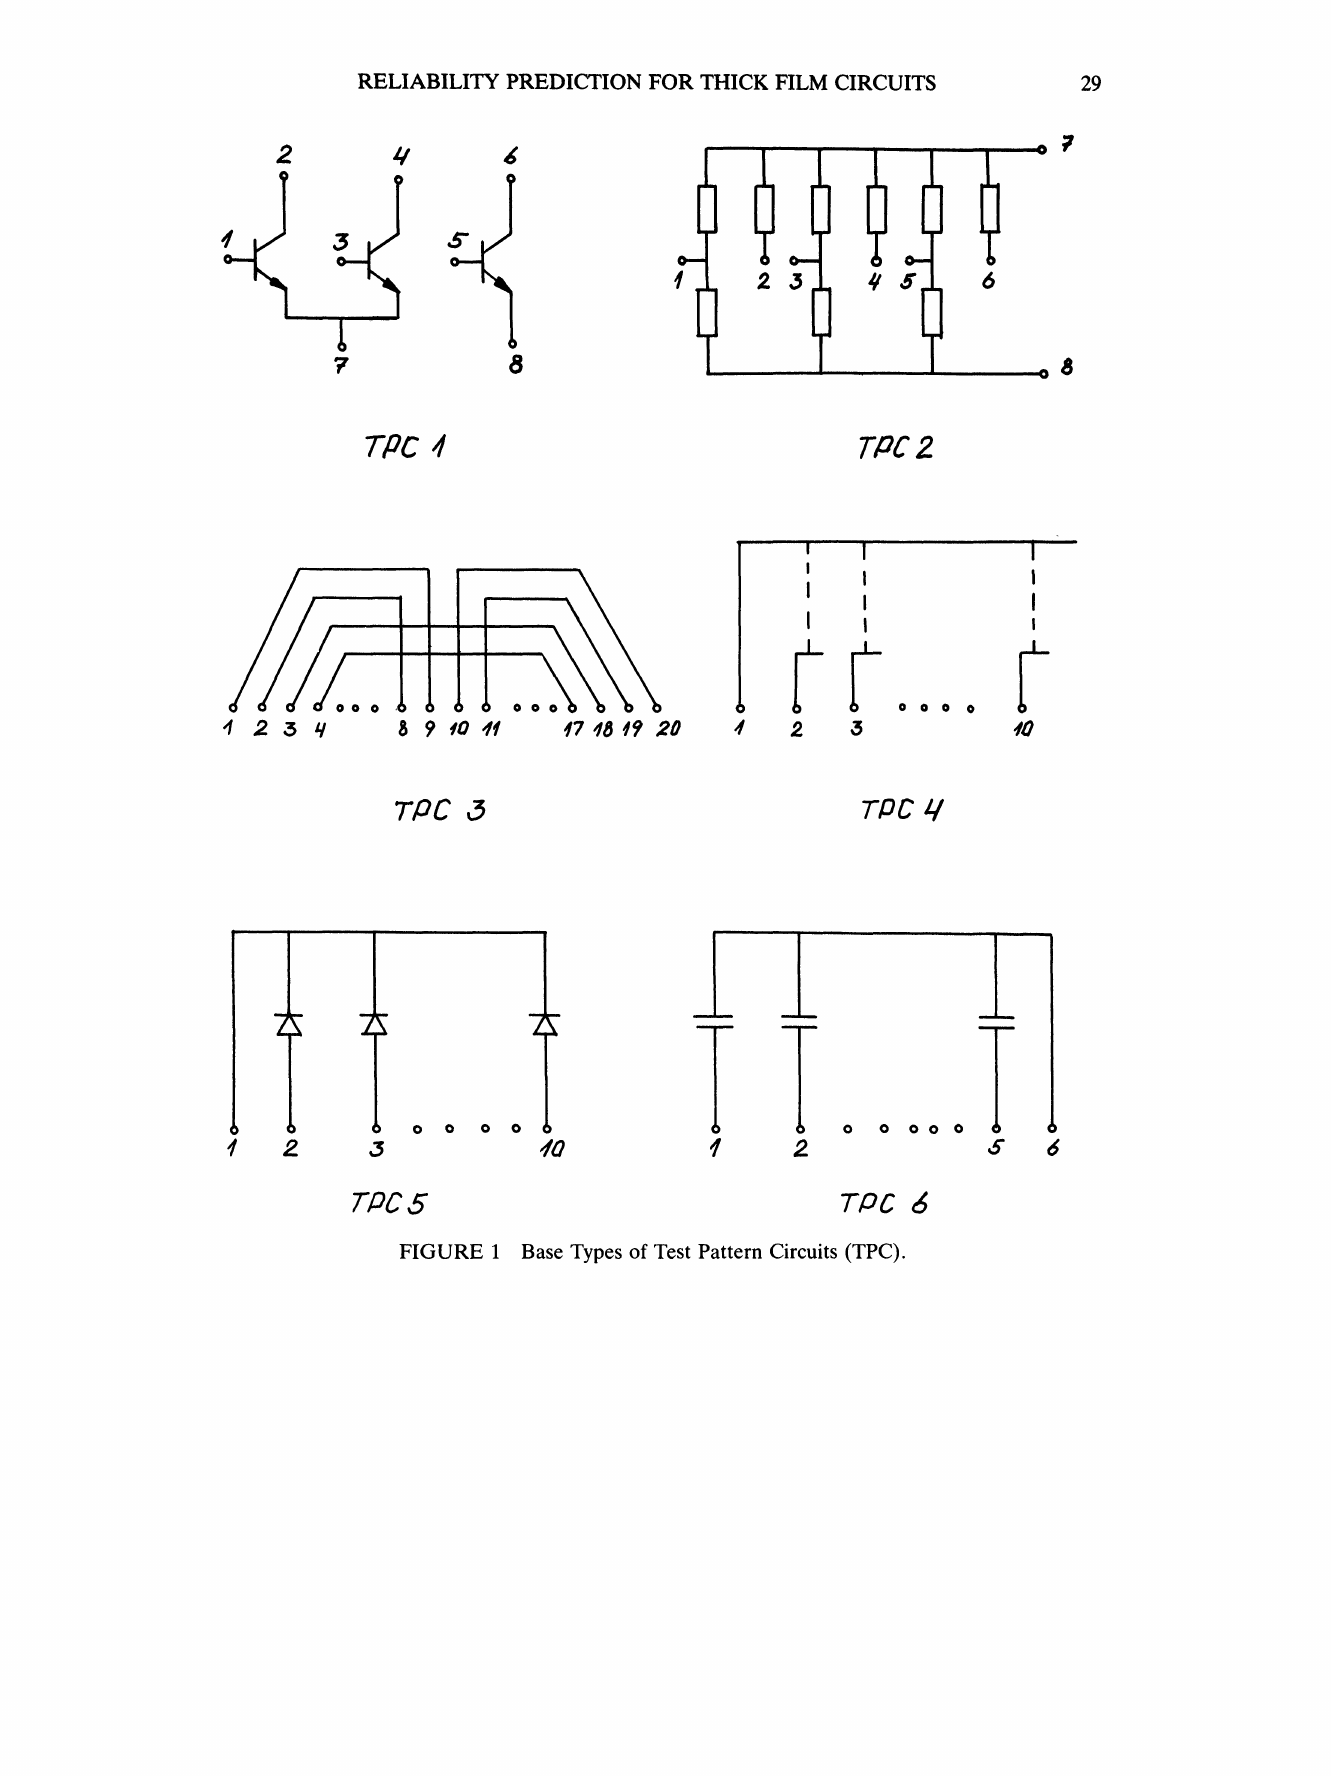
FIGURE Base Types of Test Pattern Circuits